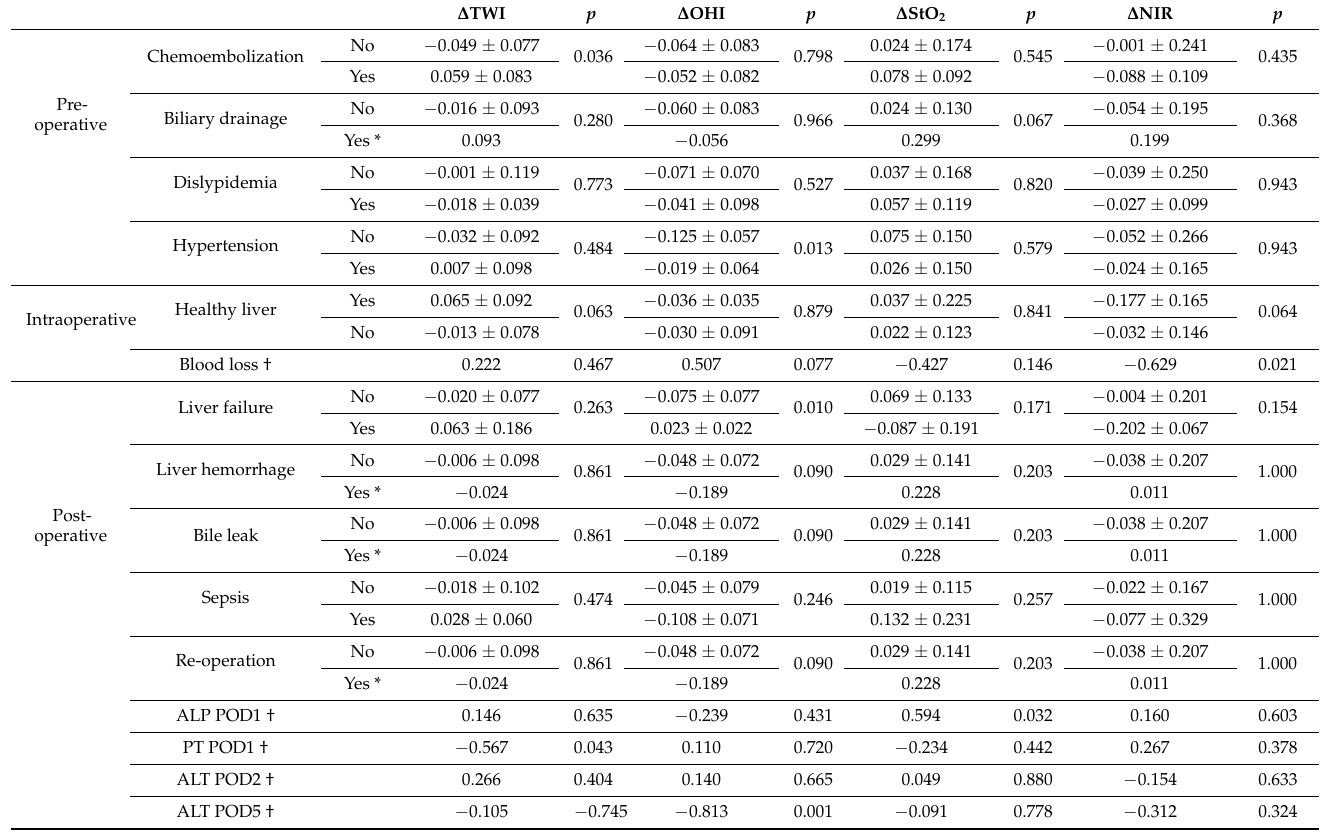
Table 4. Comparisons between differential values of hyperspectral indexes and different peri- operative